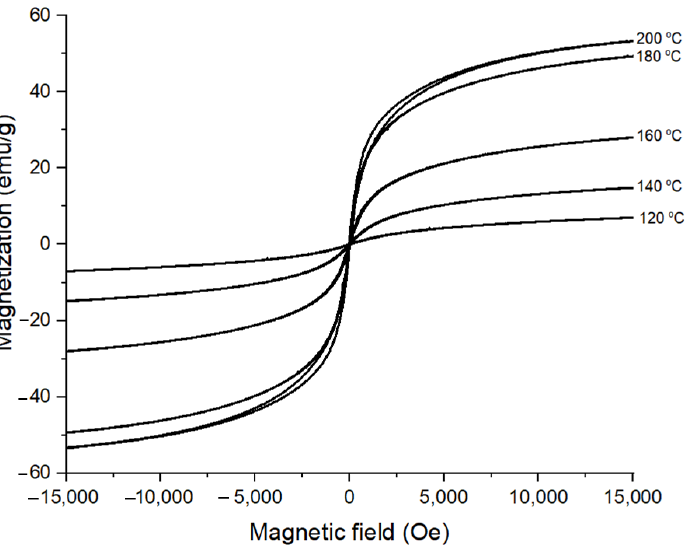
Figure 7. Room temperature M vs. H dependence of cobalt ferrite nanoparticles synthesized at 16 h in the presence of 1 M oleic acid for different reaction temperatures.